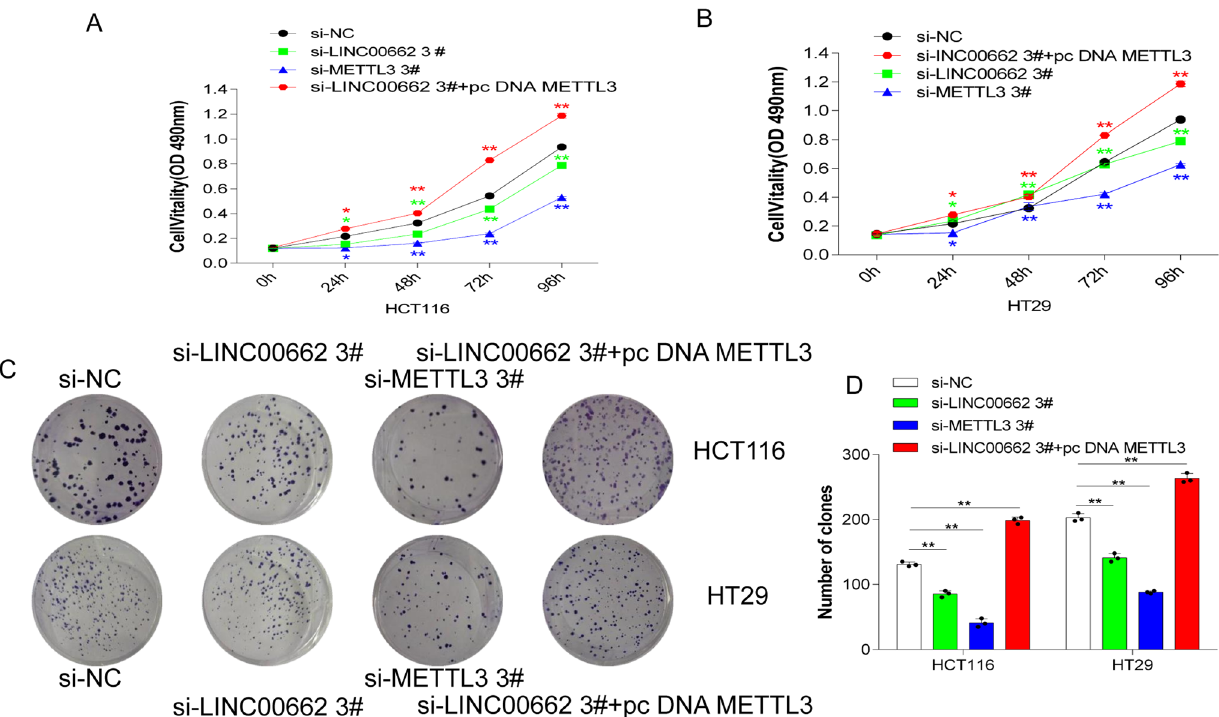
Fig. 6 METTL3 and LINC00662 promoted proliferation of CRC cells. A Cell viabilities were detected by MTT assay after interference with si-NC, si-LINC00662 3#, si-METTL3 3# and si-LINC00662 3#+ pc DNA METTL3 in HCT116 cell. MTT was added at 0 h, 24 h, 48 h, 72 h and 96 h sequentially, and DMSO was added to detect the absorbance of cells at 490 nm. B Cell viabilities were detected by MTT assay after interfer- ence with si-NC, si-LINC00662 3#, si-METTL3 3# and si-LINC00662 3#+ pc DNA METTL3 in HT29 cell. MTT was added at 0 h, 24 h, 48 h, 72 h and 96 h sequentially, and DMSO was added to detect the absorbance of cells at 490 nm. C Cell clones were counted after interference with si-NC, si-LINC00662 3#, si-METTL3 3# and si-LINC00662 3#+ pc DNA METTL3 in HCT116 and HT29 cells. D Image Pro quantification plot of colony formation